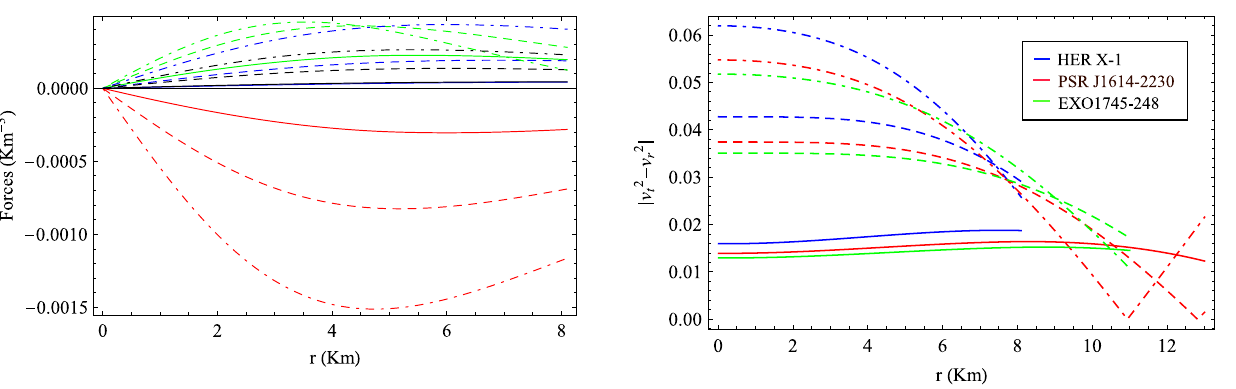
Fig. 31 Radial variation of | v 2 t − v 2 r | inside different compact objects as indicated in the figure. Here solid, dashed and dotdashed curves correspond to D = 4, D = 5 and D = 6 respectively